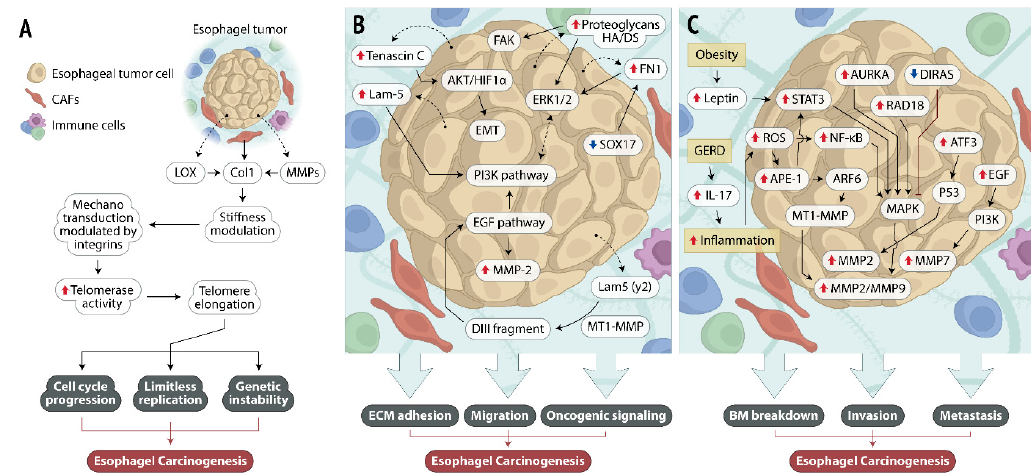
Figure 2. Mechanistic pathways involved in the reciprocal interactions between esophageal cancer (EC) cells and extracellular matrix (ECM). The figure illustrates the main molecules and signaling pathways altered along the interaction between tumor cells and ECM, which may represent fundamental steps for esophageal carcinogenesis. ( A ) Lysyl oxidase (LOX)- and matrix metalloproteinase (MMP)-altered expression in esophageal tumors is involved in the turnover of collagen molecules, resulting in ECM sti ff ness modulation that, in turn, may enhance telomerase activity, resulting in activation of signaling pathways involved with malignant phenotype acquisition, such as cell cycle progression, limitless replication, and genetic instability. ( B ) Esophageal tumor cell release increased levels of ECM adhesion molecules that activate intracellular signaling pathways involved with cell survival, enhanced cellular migration, and activation of oncogenic signaling. ( C ) Risk factors associated with esophageal tumor development (obesity and gastro-esophageal reflux disease—GERD) lead to an increase in leptin and interleukin 17 (IL-17) levels, which generates an inflammatory environment. The alterations in leptin and inflammation levels modulate the expression of several intracellular molecules that, together with other altered signaling pathways, converge to the activation of MMP expression and activity, entailing basement membrane (BM) breakdown, cellular invasion, and metastasis. Dotted arrows: molecules secreted by esophageal tumor cells; solid arrows: activation of cellular events or intracellular signaling pathways; red solid arrow: overexpressed molecules; solid blue arrow: underexpressed